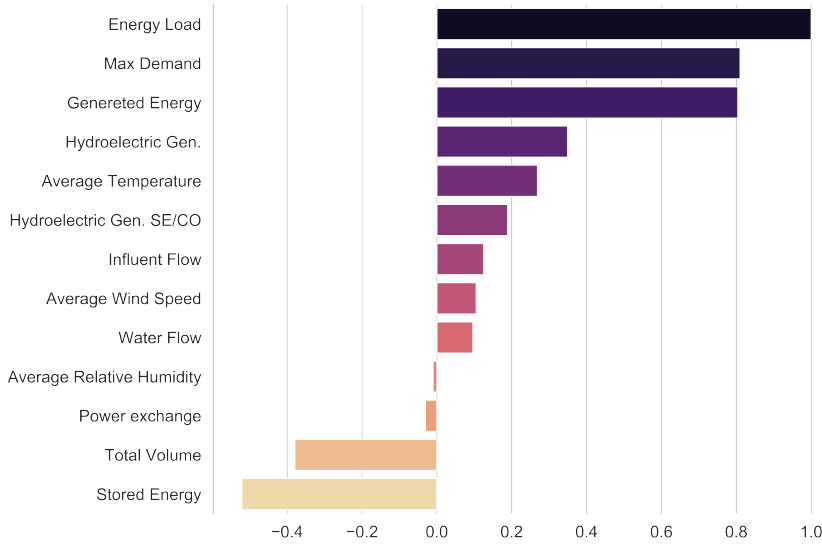
Figure 3. Pearson correlation for the Energy Load , only.